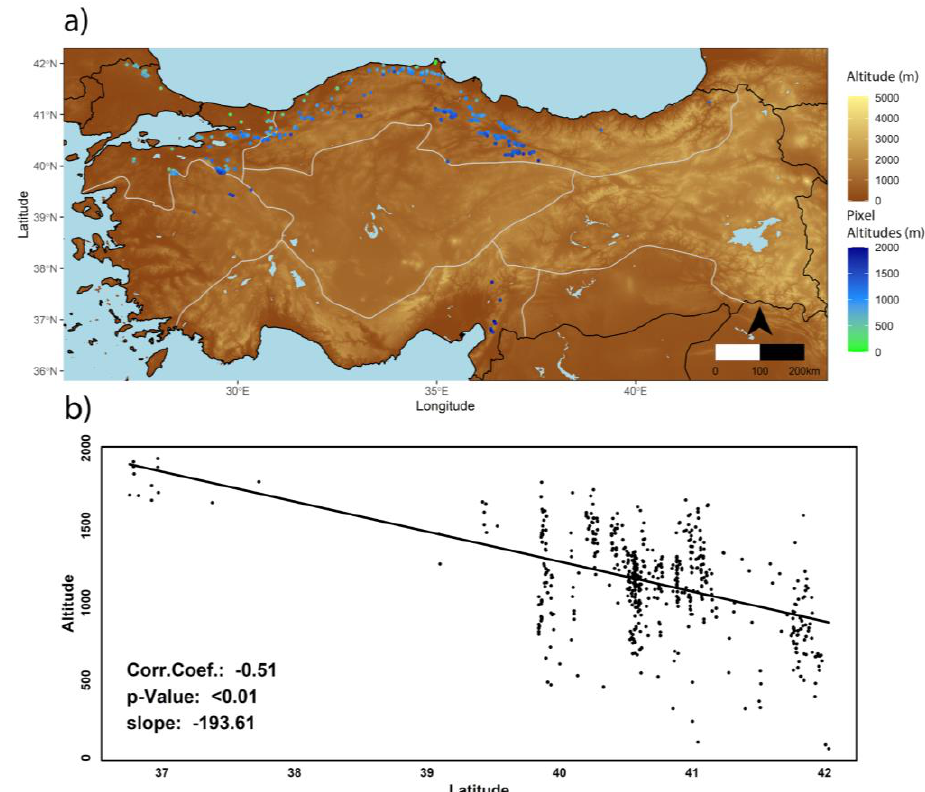
Figure 7. Respective altitudes of study pixels ( a ) and latitudinal distribution of respective altitudes of study pixels ( b ).